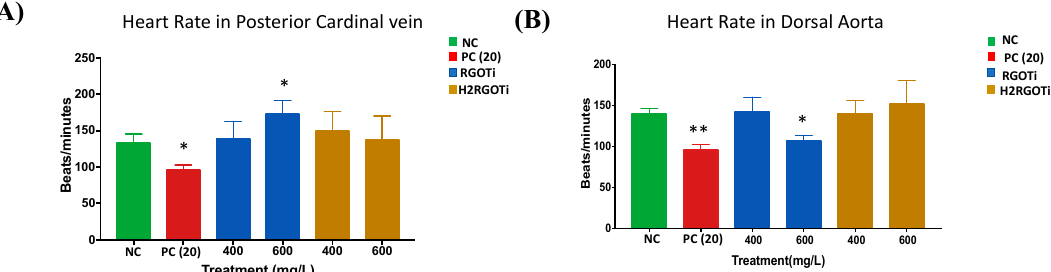
Figure 3. Effect of RGOTi and H 2 RGOTi on heart rate. Heart rate was calculated from the PCV ( A ) and dorsal aorta ( B ) of the embryos following treatment with each indicated concentration. Nineteen embryos were used per concentration. One-way ANOVA was used to compare the differences between the average of the imaged areas between groups. * p < 0.05 and ** p < 0.01, n = 10.